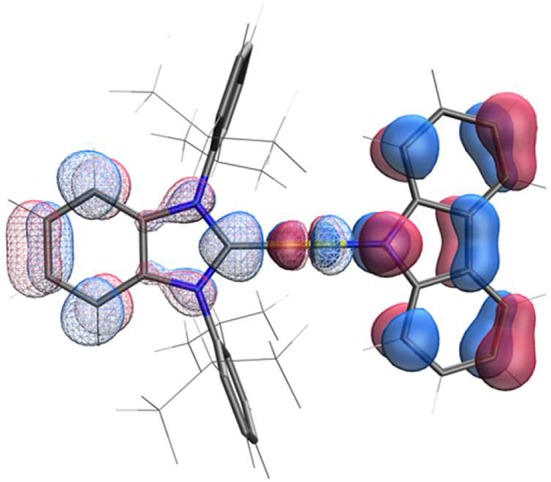
HOMO (E = 4.22 eV, solid) and LUMO (E = 1.44 eV, mesh) surfaces of complex AuBZI.